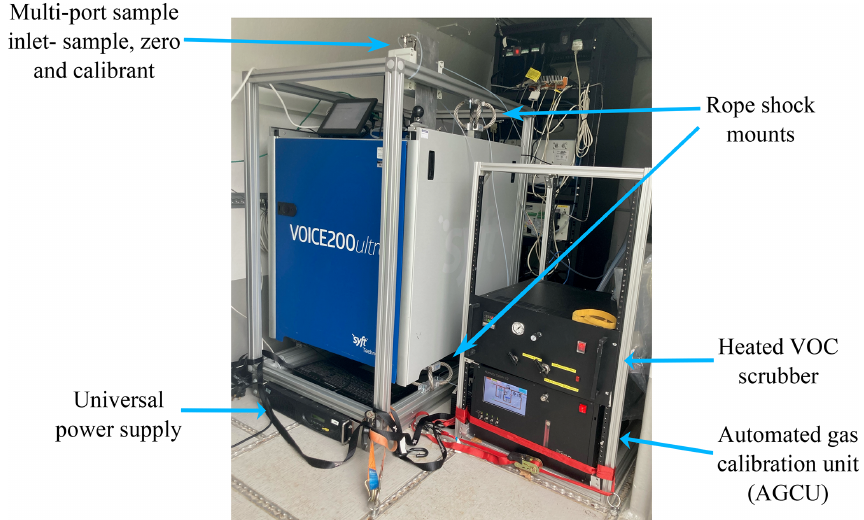
Figure 2. The Voice200 ultra SIFT-MS with in-house-built multi-port inlet and heated VOC scrubber, alongside the custom-built automated gas calibration unit (AGCU).